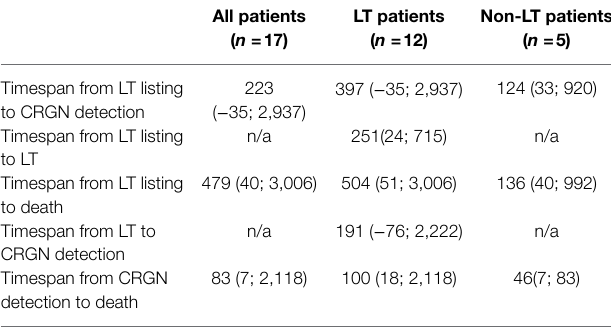
TABLE 2 | Clinical courses of CRGN patients with or without LT.